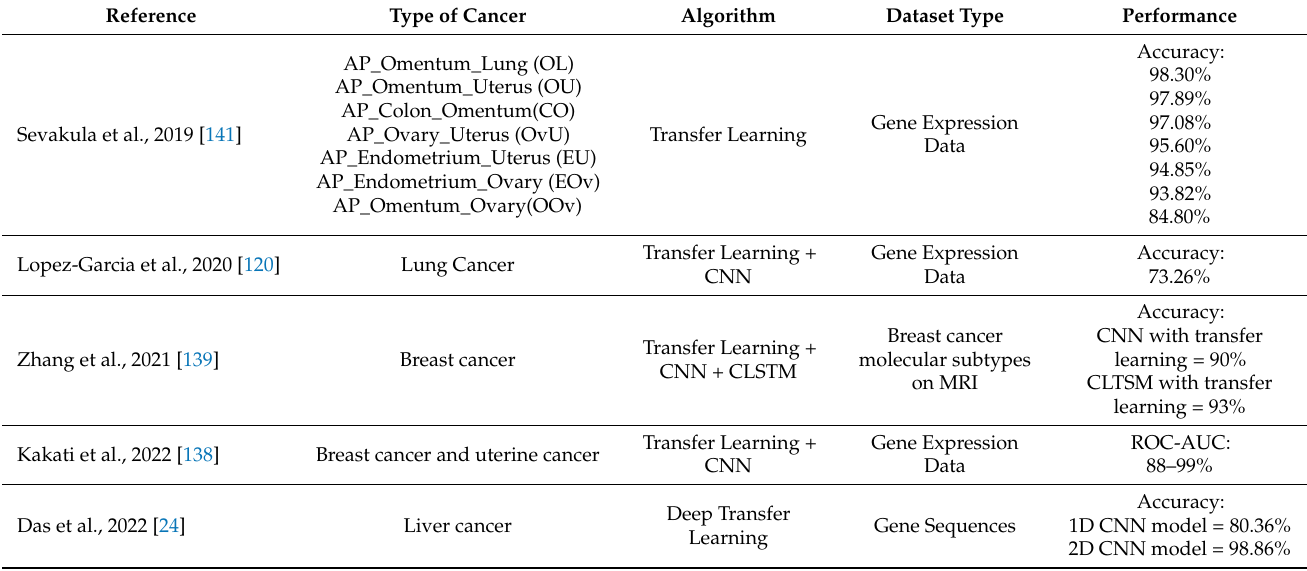
Table 10. Deep-learning-based Transfer Learning methods for gene expression